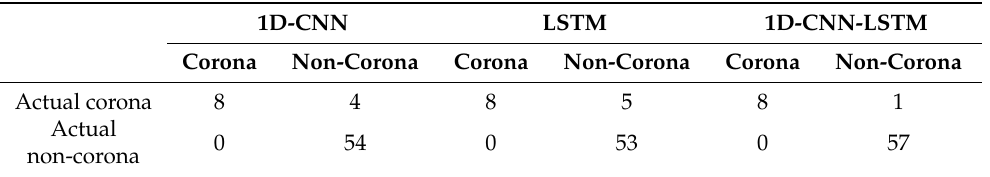
Table 9. Time domain corona fault classification output matrix for the testing phase.